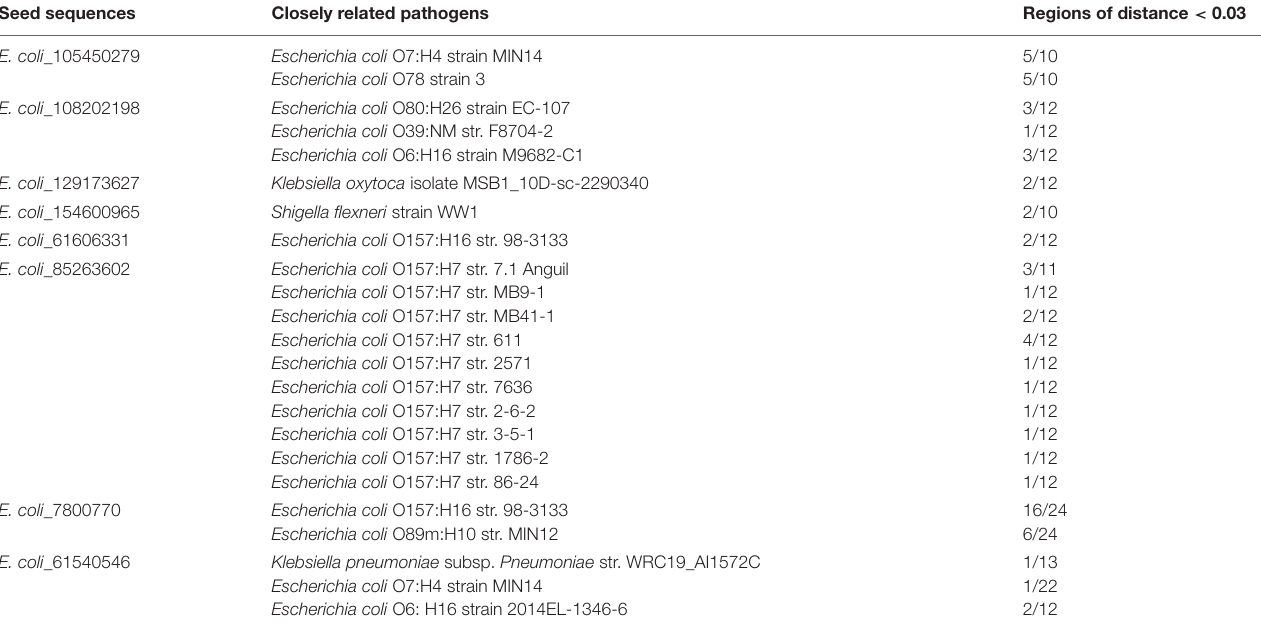
TABLE 1 | ASV1628 ( E. coli _unclassified) sequences containing regions within 0.03 Jukes–Cantor distance of known pathogens. Seed sequences Closely related pathogens Regions of distance <